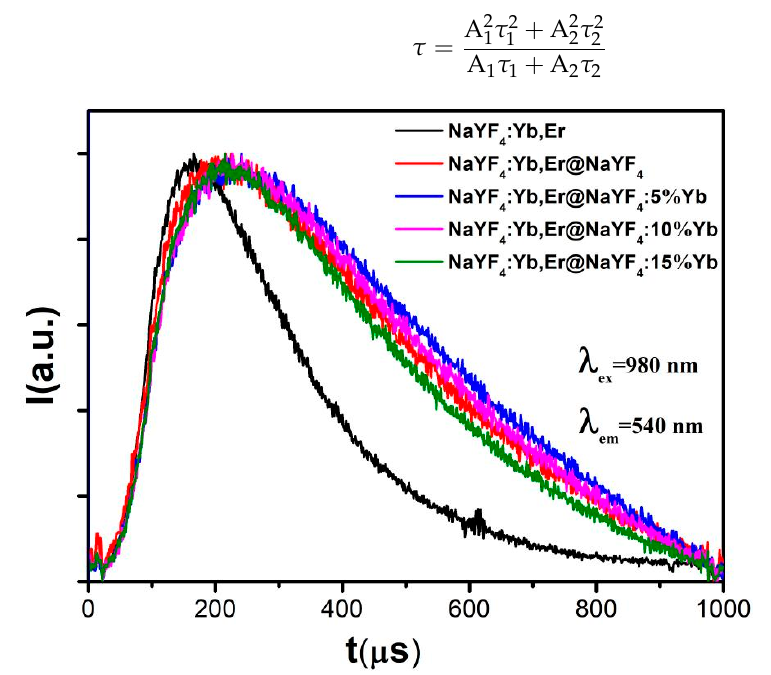
Figure 5. Energy level lifetime diagram of 540 nm from NaYF 4 :Yb 3+ ,Er 3+ and NaYF 4 :Yb,Er@ NaYF 4